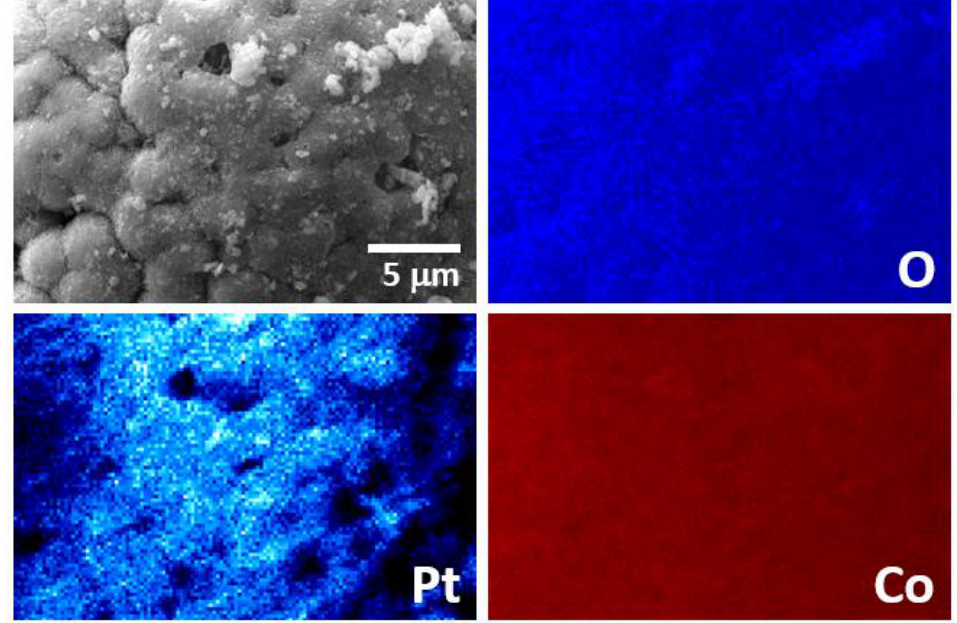
Figure 10. EDX element mapping of Pt 2.5 Co 97.5 tested in 10 cycles of NaBH 4 hydrolysis and washed.